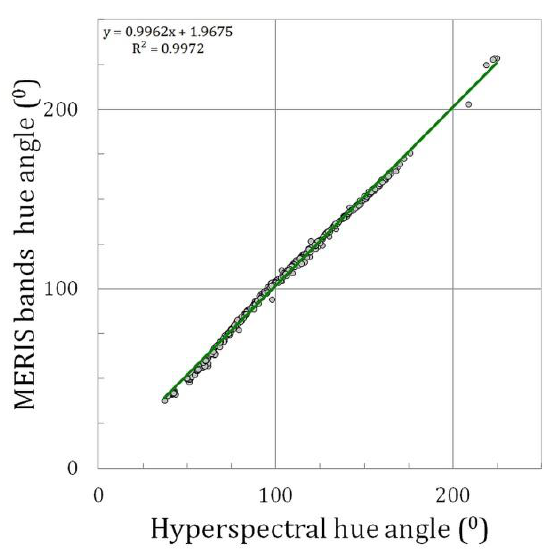
Figure 7. Example of the hue angle (“the colour”) reconstruction for MERIS. Hyperspectral hue angle (TriOS-Ramses) versus MERIS band hue angle after polynomial fit. The plot includes the linear fit